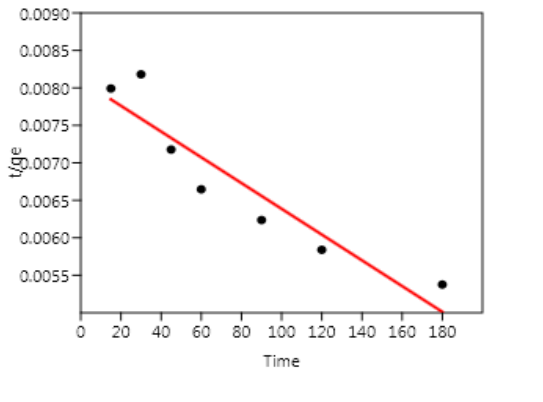
Figure 12. The pseudo-first-order kinetics of ammonia ad - sorption by chitosan-activated carbon nanocomposite